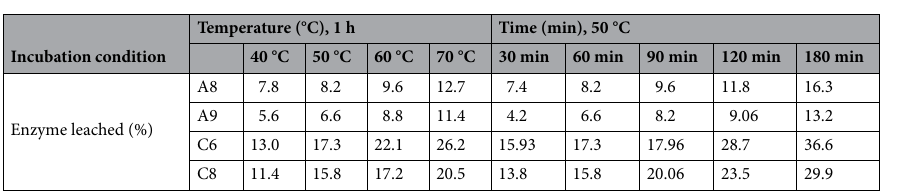
Table 3. Enzyme leached out (%) at various incubation temperatures/times from immobilized SA-based (A8, A9), and CH-based (C6, C8) hydrogel samples.